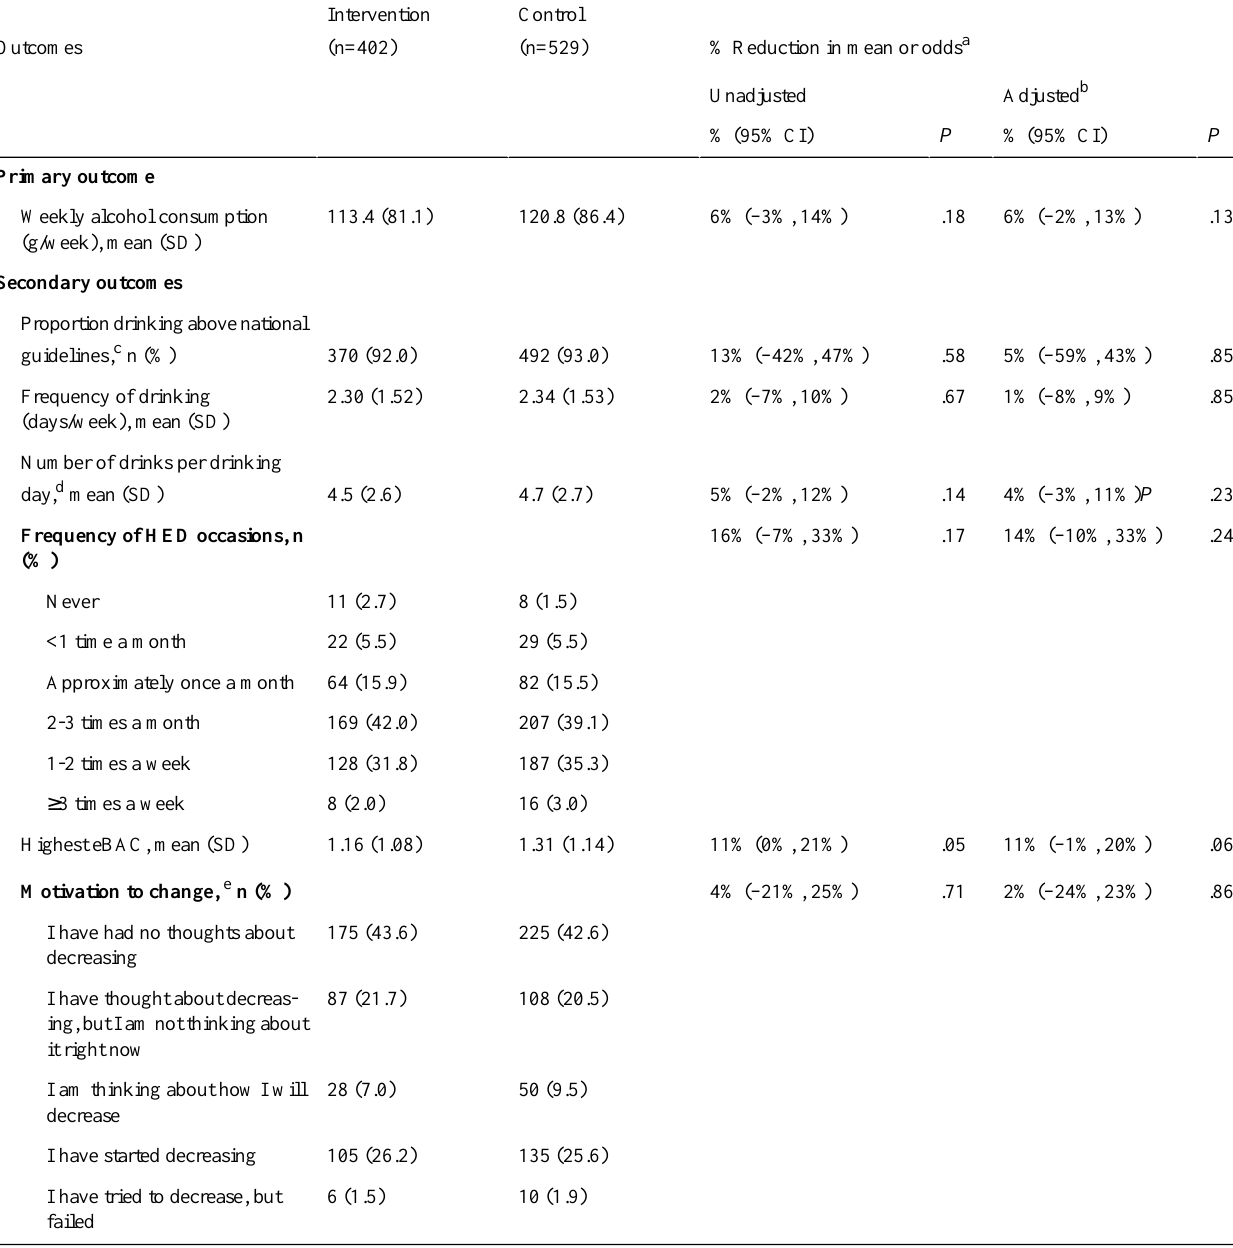
Table 3. Trial outcomes (n=931).